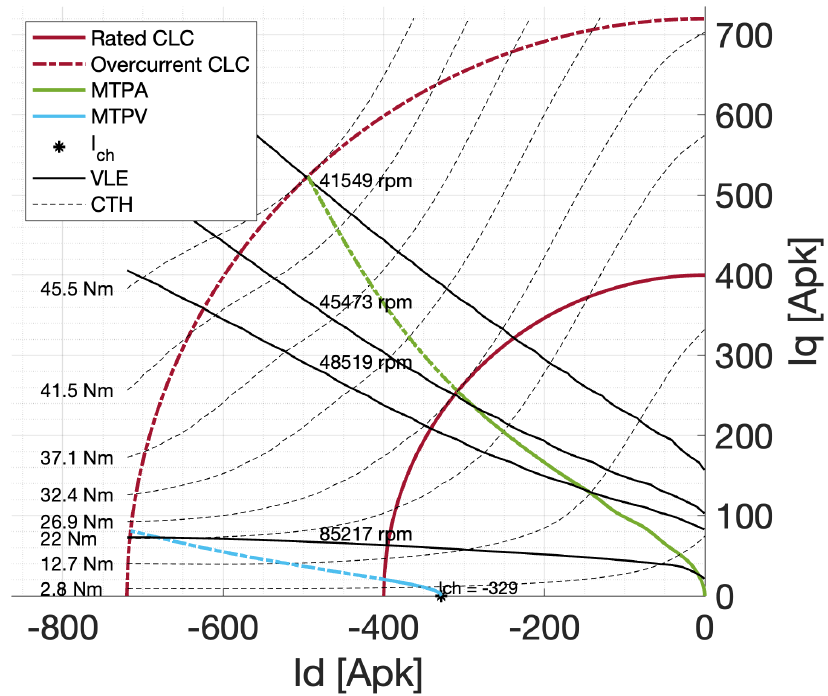
Figure 9. Control trajectories on the d-q plane computed with a Standard Method. The Voltage Limit Ellipses (black solid lines) are very different from the ideal ellipses of the conventional linear model (where the L d and L q are assumed to be constant). Specifically, on the left side of the d-q plane the ellipses moves away from the d -axis. Similarly to the case of MTPA, the linear model is less accurate when the amplitude of the current vector increases. These phenomena cause differences in the MTPA base speed and FW limit speed. On the other hand, the characteristic current point [ I ch ; 0 ] is similar for both the approaches, falling inside the rated current limit